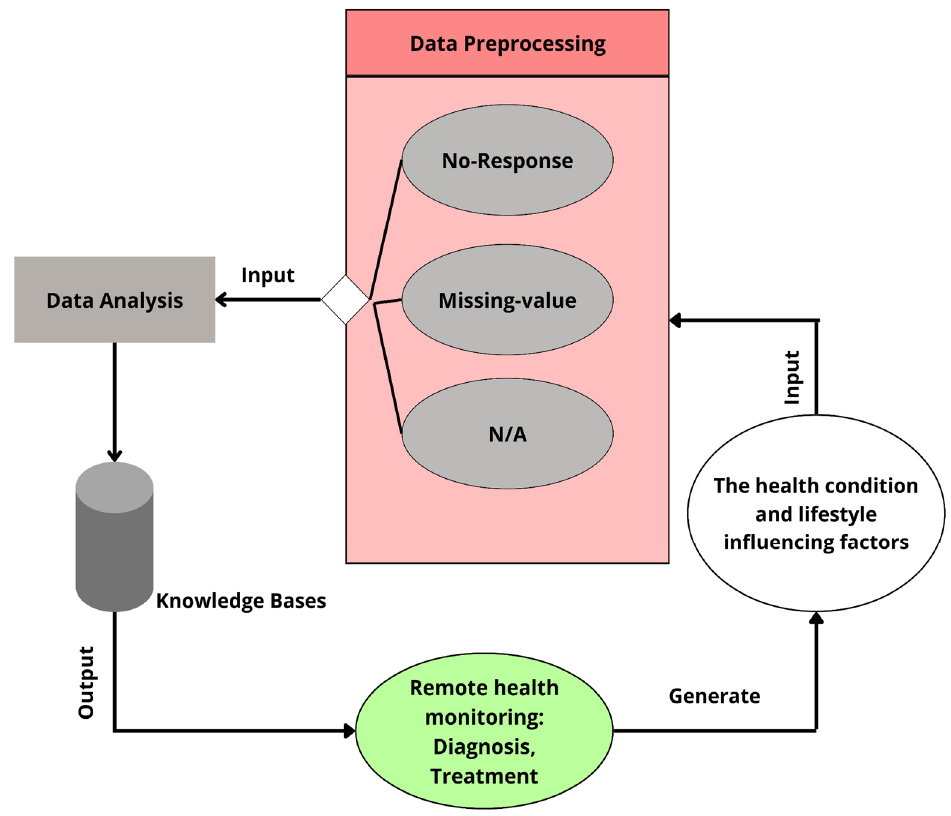
Figure 15. Data processing model of EHRs for remote monitoring.